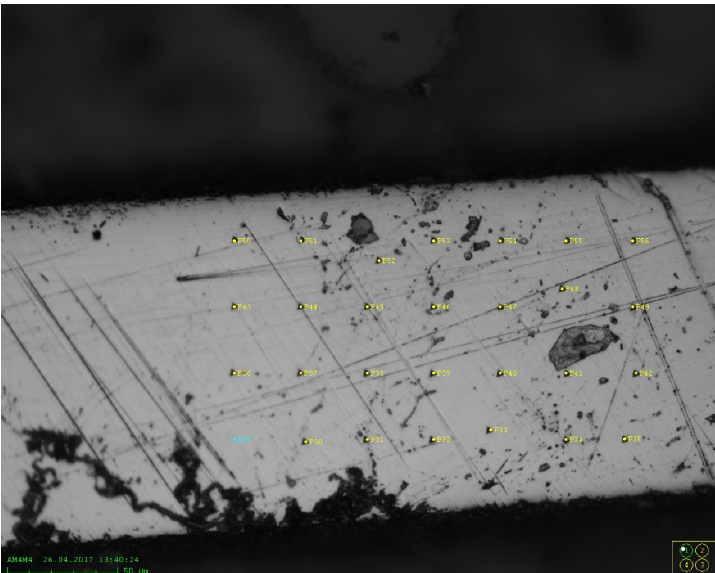
Figure 10. Micrograph (1000X) of an indentation matrix located on the surface of a steel microfiber showing all 28 indentation points ~30 µm from each other, distributed in 7 columns and 4